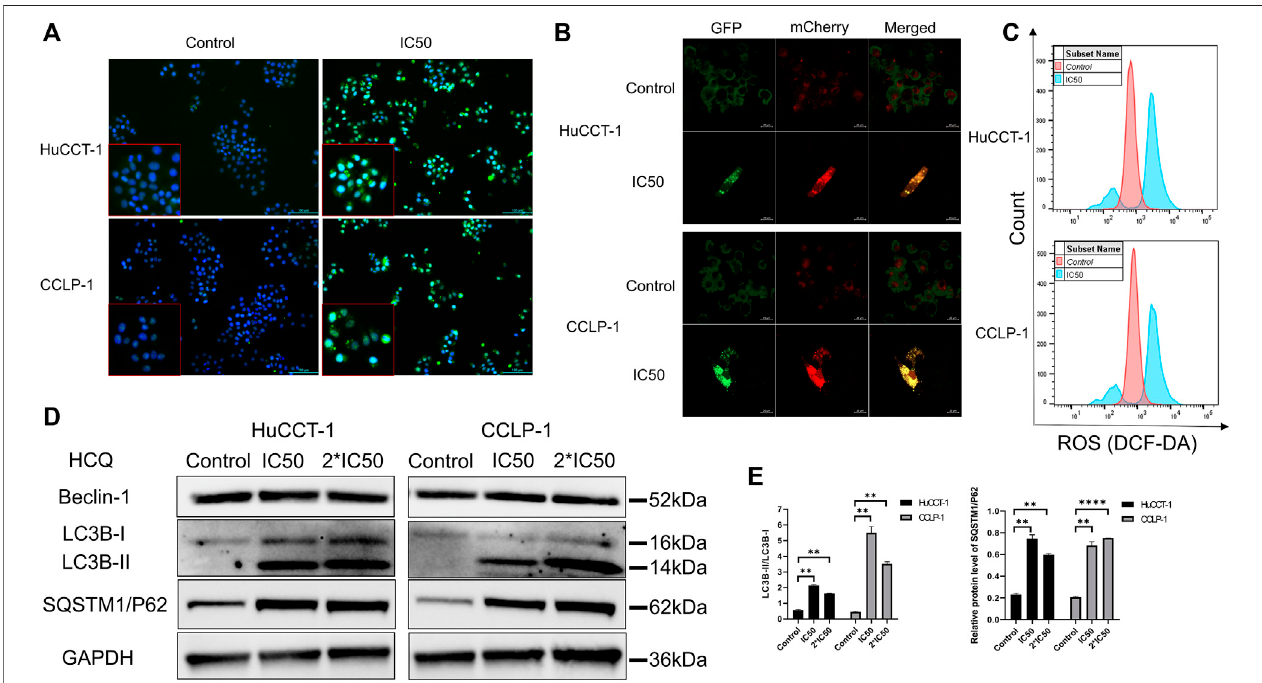
FIGURE 5 | HCQ inhibits autophagy and causes ROS accumulation in cholangiocarcinoma cells. (A) Autophagy inhibition was observed by immuno fl uorescence microscopy (blue fl uorescence indicates Hoechst and green fl uorescence indicates LC3B puncta) after HCQ (IC50) treatment for 24 h. (B) Autophagy fl ux was inhibited in both cell lines after HCQ treatment. (C) ROS levels of HuCCT-1 and CCLP-1 cells treated with HCQ were determined by FCM. (D) Expression of Beclin-1, LC3B, and SQSTM1/P62proteinswasdetected bywesternblottinginHuCCT-1 and CCLP-1 cellstreatedwithIC50 and2*IC50concentrationsofHCQ. (E) Quanti fi cation of LC3B and SQSTM1/P62 proteins. Data are expressed as mean ± SD. ** p < 0.01, **** p < 0.0001, signi fi cant difference compared with the control